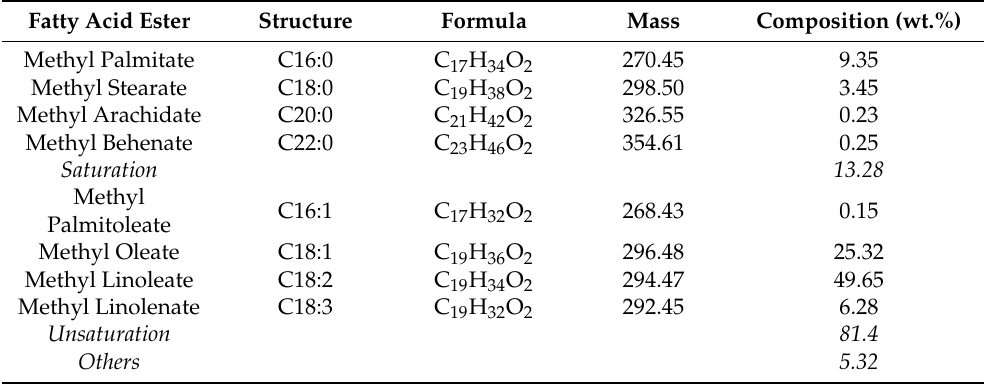
Table 1. Fatty acid composition of waste oil